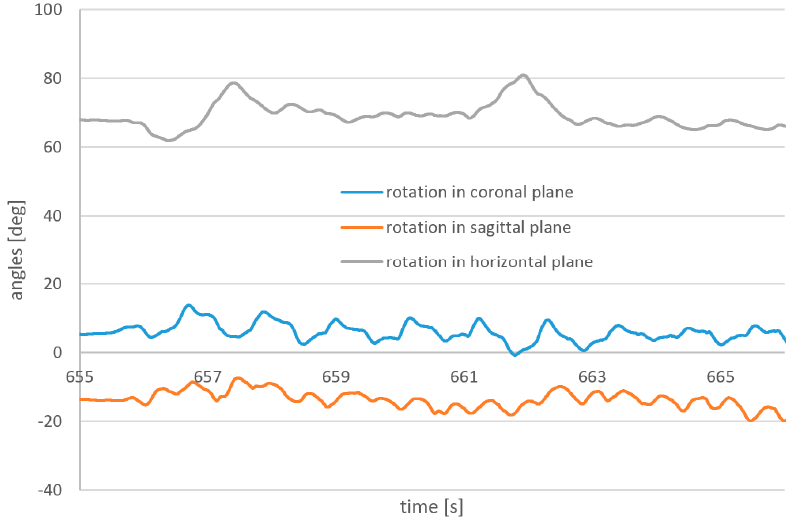
Figure 24. Angles measured on the head during walking by the flight controller.